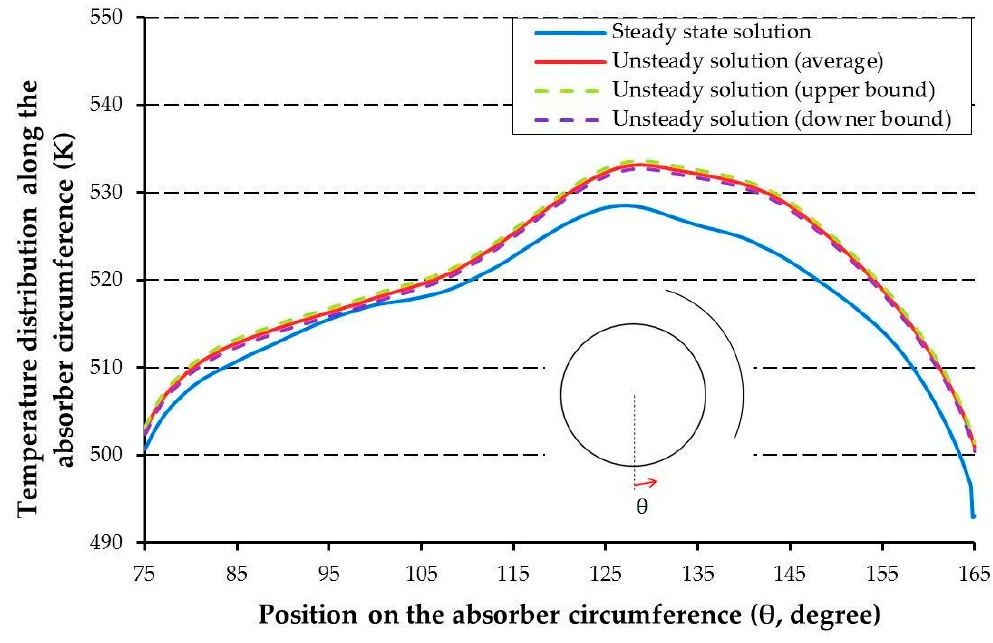
Figure 6. Temperature distribution along the outer surface of the absorber while temperature of the kiln is constant.